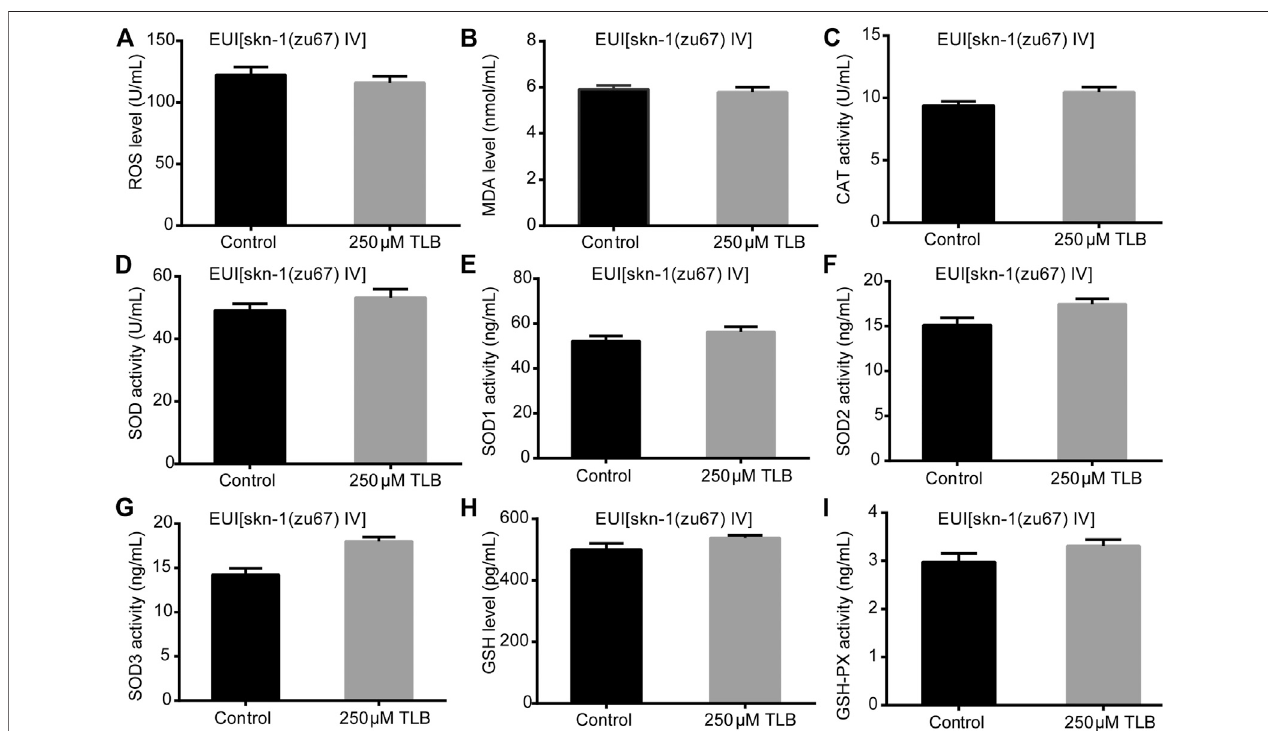
FIGURE5| Anti-oxidanteffects ofTLB inSKN1mutant C.elegans . C.elegans wereraisedintheabsenceor presence of250 μ MTLBfor72 h. Thetotalprotein of C. elegans was extracted and centrifuged for 10 min at 10,000 × g, 4 ° C, then the supernatant was detected using appropriate ELISA kits according to the manufacturer ’ sprotocol. (A) ROSlevel; (B) MDAlevel; (C) CATactivity; (D) SODactivity; (E) SOD1activity; (F) SOD2activity; (G) SOD3activity; (H) GSHactivity; (I) GSH- Px activity. n (cid:2) 1000. Data were presented as mean ±